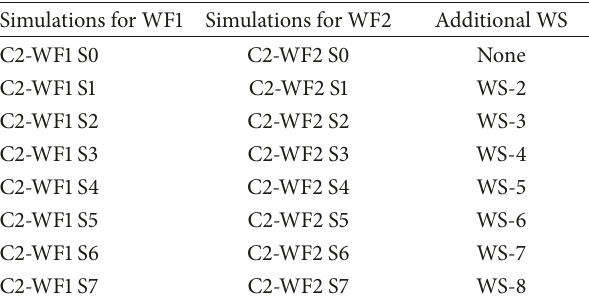
Table 5: Simulations studied in Case